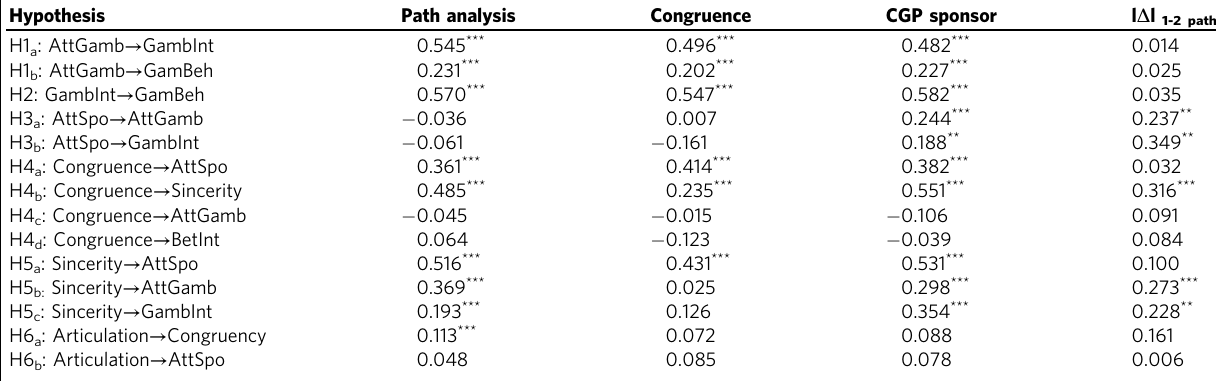
Table 7 Multi-group